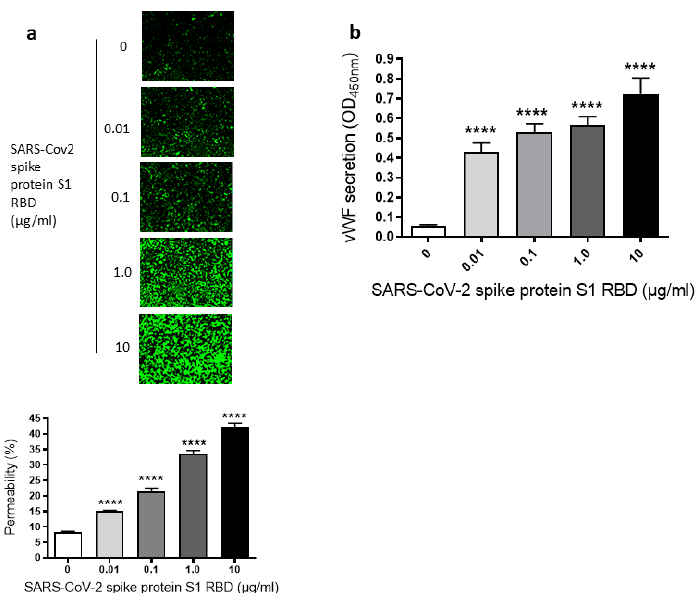
Figure 2. Dose-dependent effect of SARS-CoV-2 spike S1 RBD on EA.hy 296 cell monolayer per- meability and vWF secretion. ( a ) Visualization at 10 × magnification of 0–10 µ g/mL SARS-CoV-2 spike S1 RBD-induced permeability in EA.hy 296 cell monolayer. ( lower panel ) Represents the quantification data of ( a ). ( b ) vWF secretion by EA.hy 296 cell monolayers treated with 0–10 µ g/mL RBD for 72 h. Statistical significance was measured by one-way ANOVA comparing the treated with the untreated control (**** p <